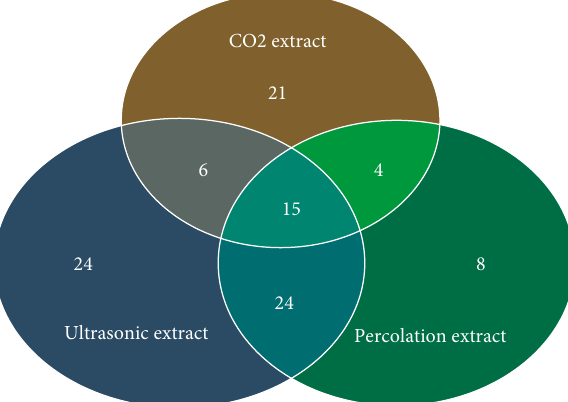
Figure 1: Venn diagram of the distribution of phytochemical